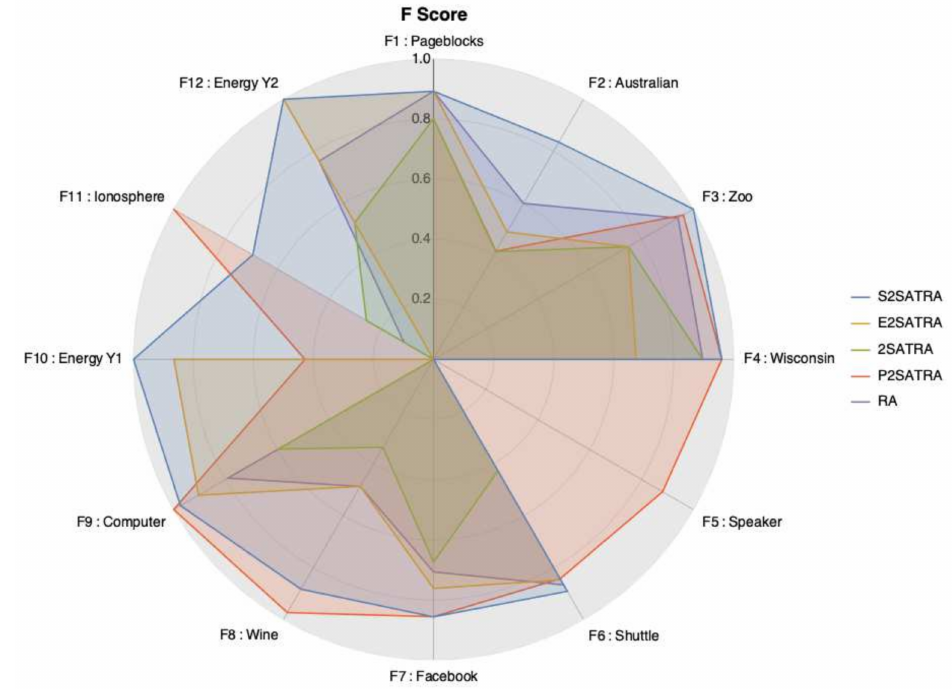
Figure 14. F-score for all logic mining